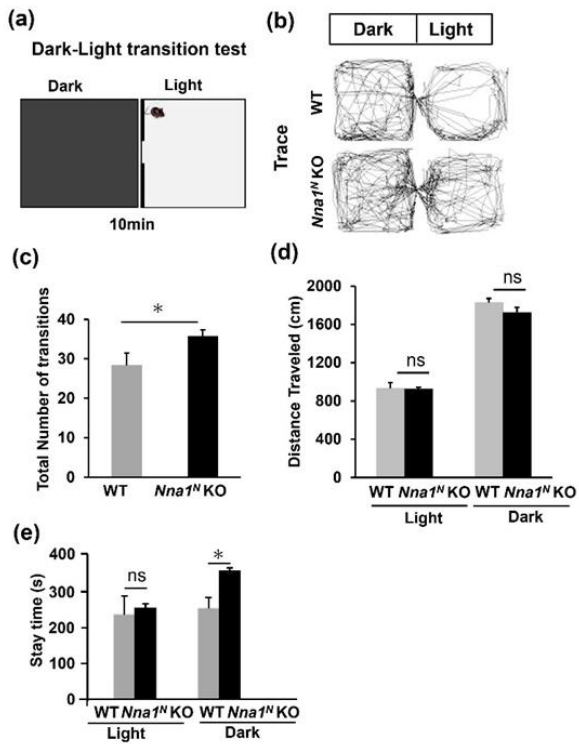
Figure 4. Anxiety-related behavior in Nna1 N KO mice observed by the light-dark transition test. ( a ) Schematic representation of the light-dark transition test. ( b ) Representative traces showing the movement of WT and Nna1 N KO mice separately in the light-dark transition test. ( c ) Nna1 N KO mice showed more transition latency than WT mice. ( d ) No significant difference was observed between Nna1 N KO and WT mice in the travel distance in the boxes. ( e ) Nna1 N KO mice showed more stay time in the dark box than the control mice. WT, n = 6; Nna1 N KO, n = 10, * p < 0.05, Student’s t -test. All values presented are means ± SEM. “ns” means not